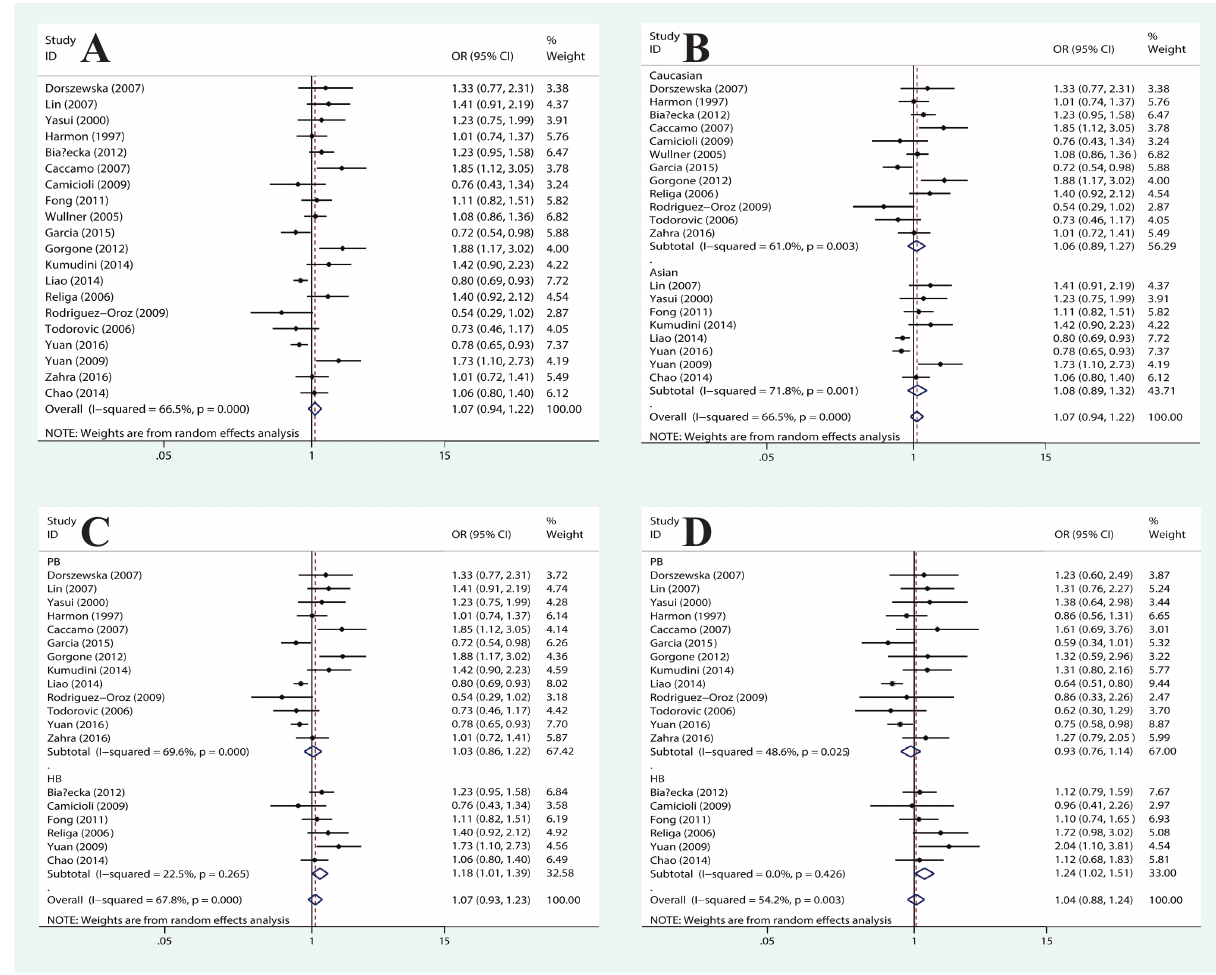
Figure 2: Forest plot of the association between MTHFR C677T polymorphism and PD susceptibility: (A) allelic genetic model in the overall populations; (B) allelic genetic model, stratified by ethnicity; (C) allelic and (D) co-dominant genetic model, stratified by source of